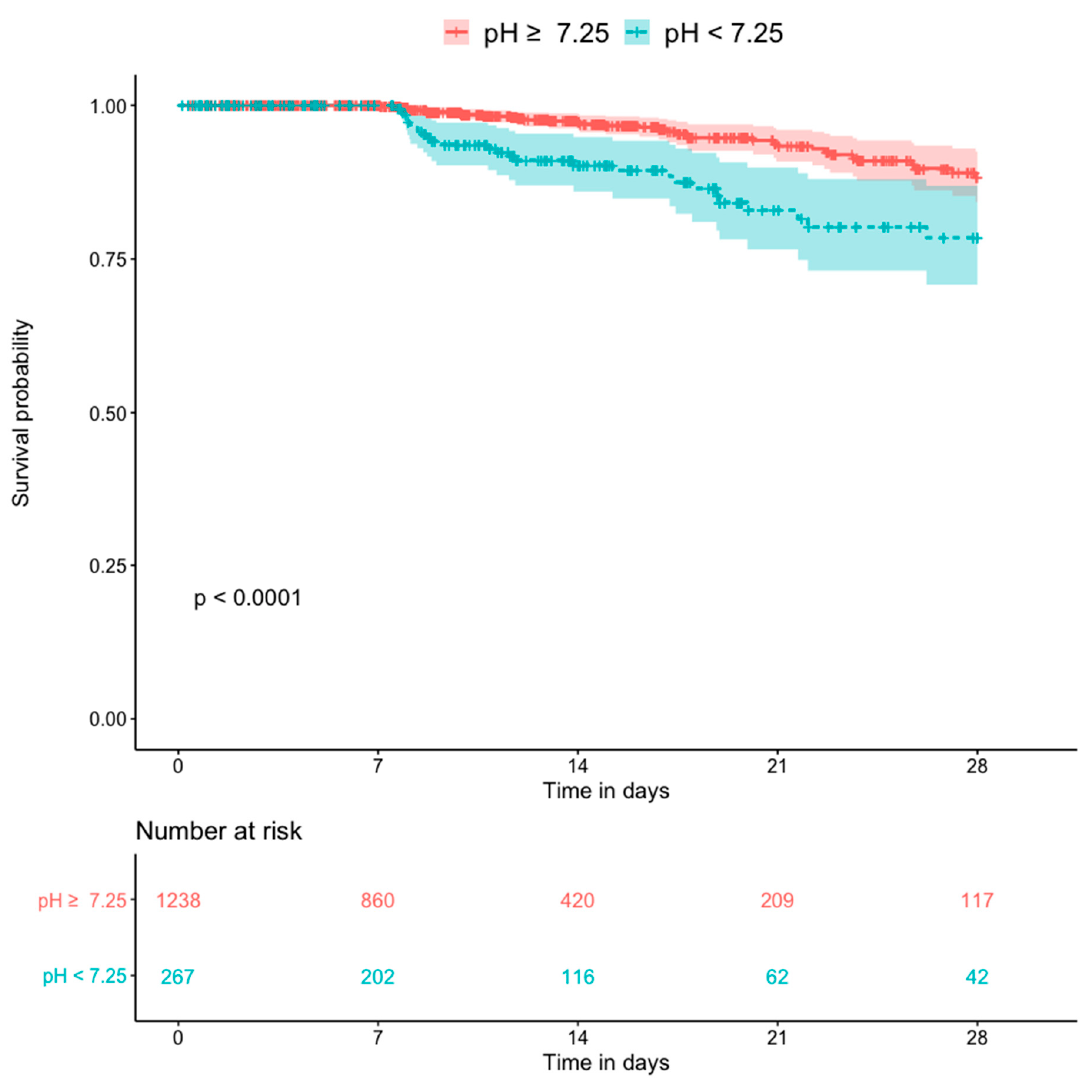
Figure 6. Kaplan–Meier plot for 28-day death compared by the pH (n = 1505).